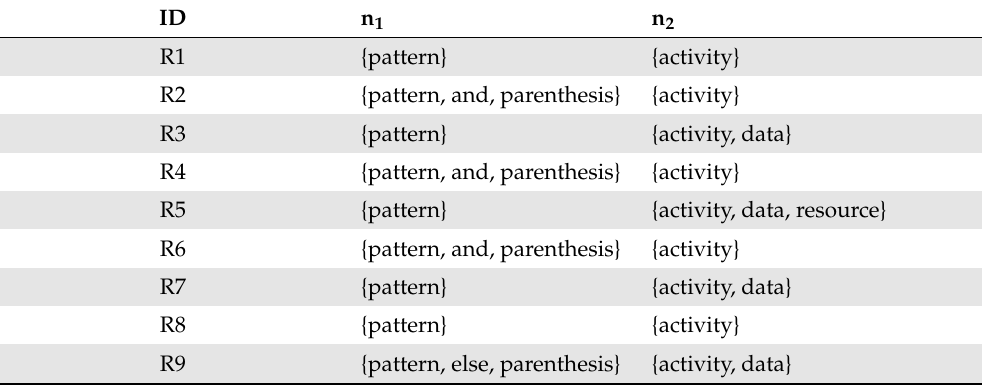
Table A3. Definitions on CRL